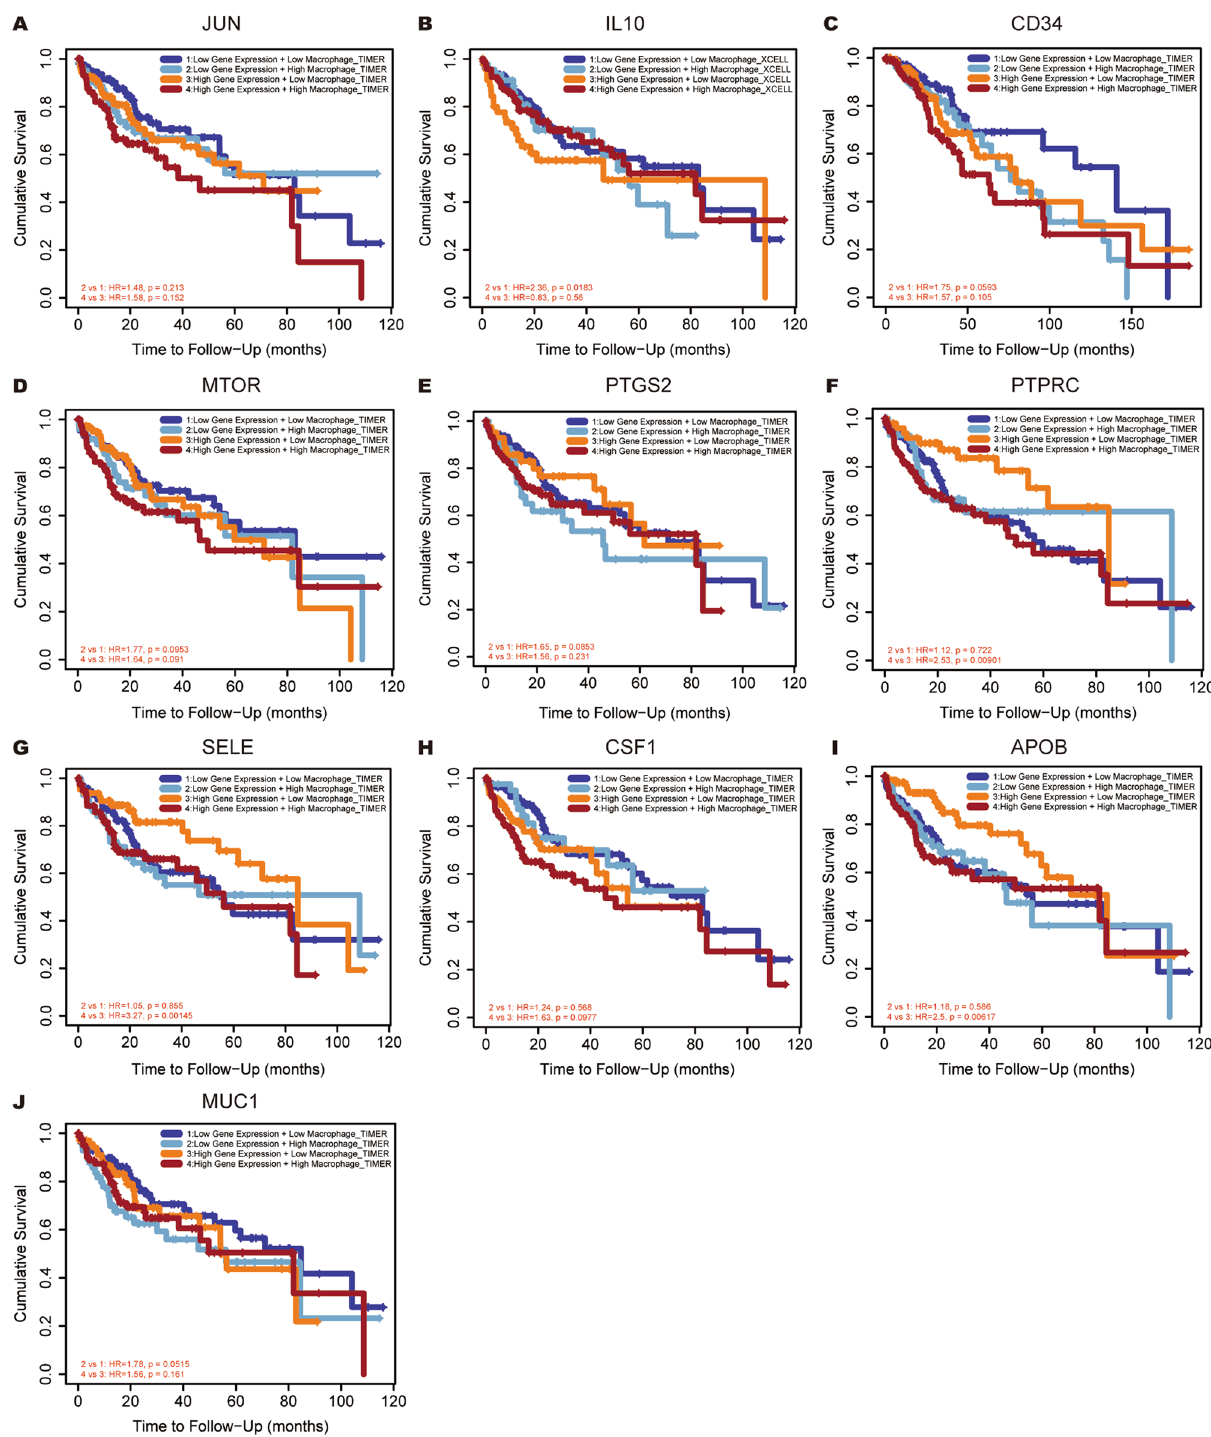
Figure 12. Overall survival analyses for combining the expression of single hub gene with macrophage in HCC patients after adjusting five confounding factors, including age, stage, gender, race, and tumor purity. ( A ) JUN, ( B ) IL10, ( C ) CD34, ( D ) MTOR, ( E ) PTGS2, ( F ) PTPRC, ( G ) SELE, ( H ) CSF1, ( I ) APOB, ( J )